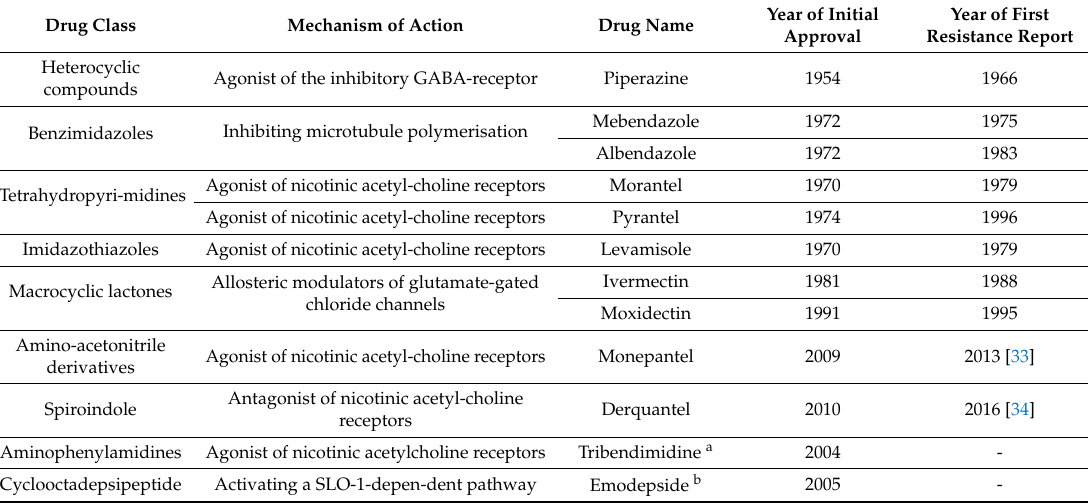
Table 1. Anthelmintic drugs for intestinal nematode infections in human and / or veterinary medicine (modified from